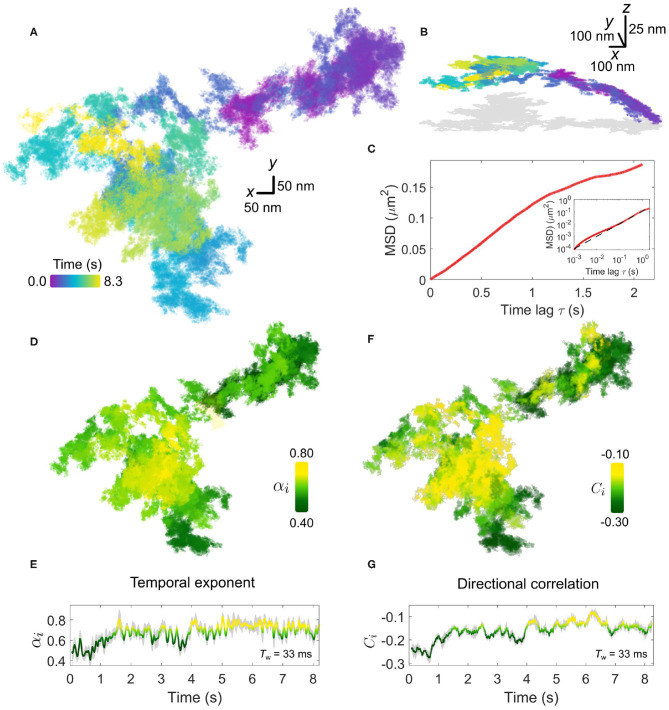
Anomalous EGFR diffusion in the plasma membrane revealed by high-speed iSPT. (A) A typical EGFR-GNP trajectory recorded with 30,000 frames per second for a duration of 8.3 s on a COS-7, here shown as x-y plane. (B) The trajectory from (A) viewed in 3D, revealing global curvature. The 2D projection is depicted in gray. (C) The whole-trajectory MSD. Inset shows the same plot but on a log-log scale with a linear slope as a guide to the eye. (D) The rolling temporal exponent of diffusion αi for the trajectory for an incrementally sliding window of 1,000 frames (Tw = 33 ms), represented by the color scale, mapped onto the x-y trajectory. (E) The temporal exponent plotted as a function of time. (F) Similar to (D), the rolling directional correlation Ci is mapped onto the x-y trajectory and also expressed as a function of time (G). The gray shadow in (E,G) show the bounds of uncertainty in calculation of each respective quantity.